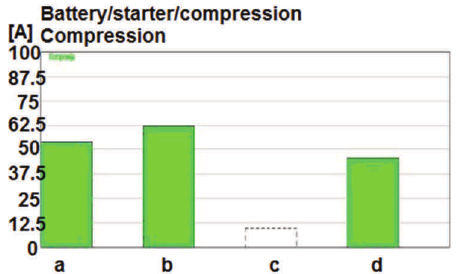
Fig. 11 Relative compression for one spark plug current for two spark plugs